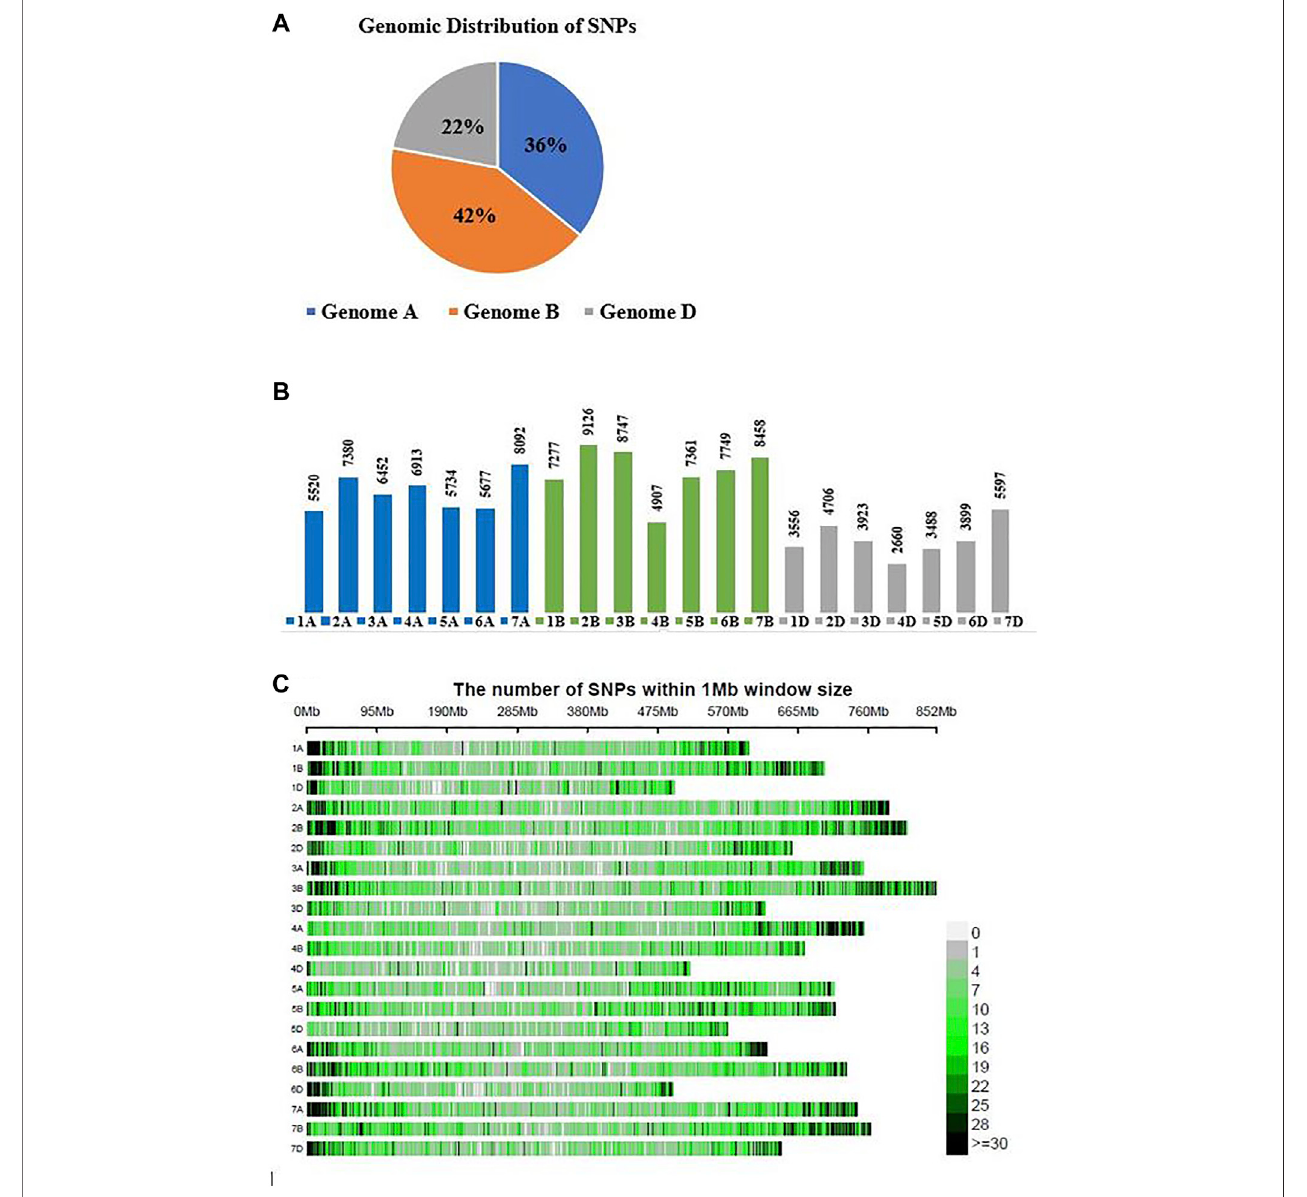
FIGURE 1 | (A) Sub-genomic distribution of 123,596 SNPs on three sub-genomes of spring wheat. (B) Chromosomal SNPs distribution on each chromosome of three sub-genomes (A, B, D), (C) Number of SNPs within 1 Mb window size.